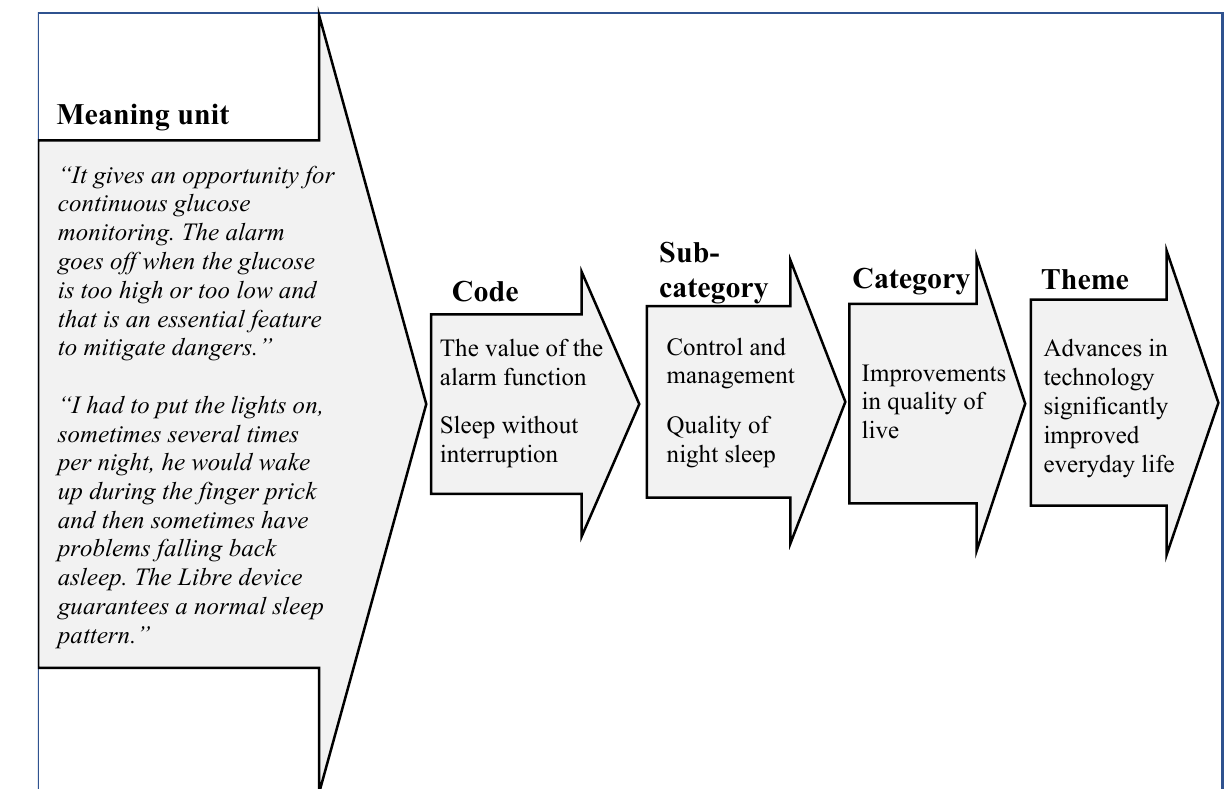
Figure 1. Example of the analysis process, from meaning unit to main theme. Collected demographic values were analysed with the statistical software SPSS ® version 27.0 (SPSS Inc., Chicago, IL, USA). Parents’ and children’s demographics are presented as absolute- and relative frequencies and the age of the children was clustered in the following groups: 0–3, 4–7, 8–12, and 13–16 years. An Overall satisfaction with the Libre device is described with a median (Md) and interquartile range (IQR) value, graded on a 10-point Likert scale (1 = Not at all satisfied; 10 = Completely satisfied).